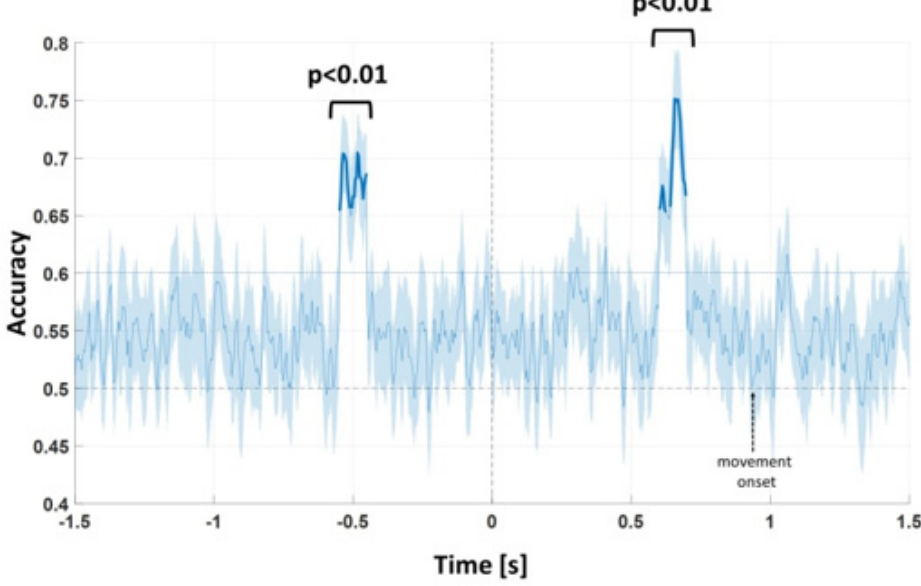
Figure 3. Time course of cross-validated LDA classifier (mean and standard errors across the cross- validation folds) in the time interval from − 1200 to 1000 ms. Intervals in which the classifier performs higher than chance level are indicated ( p < 0.01). Timing of the foot pedal response is indicated in the figure (~920